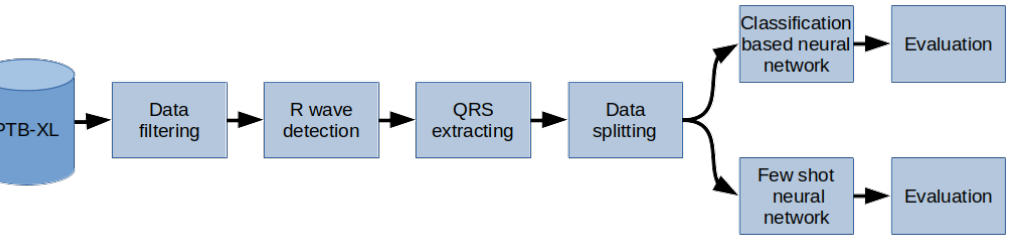
Figure 2. General overview diagram of the